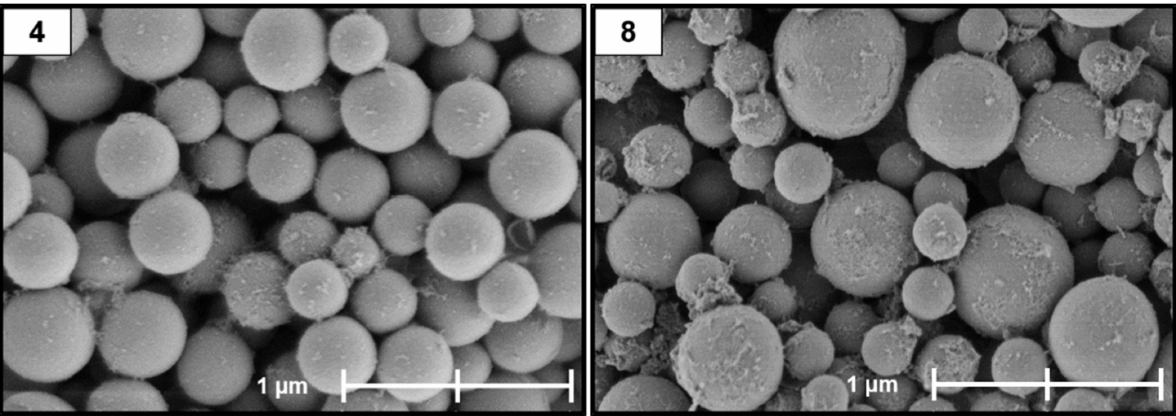
Figure A3. SEM image of filtrates with secondary particles of HB4 and HB8 at 50,000 × magnification.